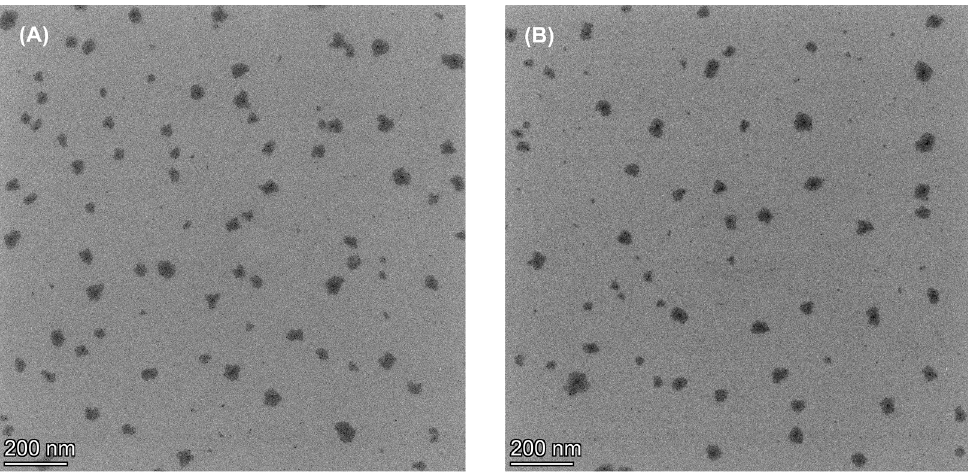
Figure 6. Microscopic morphology photograph of ( A ) FPM7 and ( B ) FPM8 by transmission electron microscope (TEM).